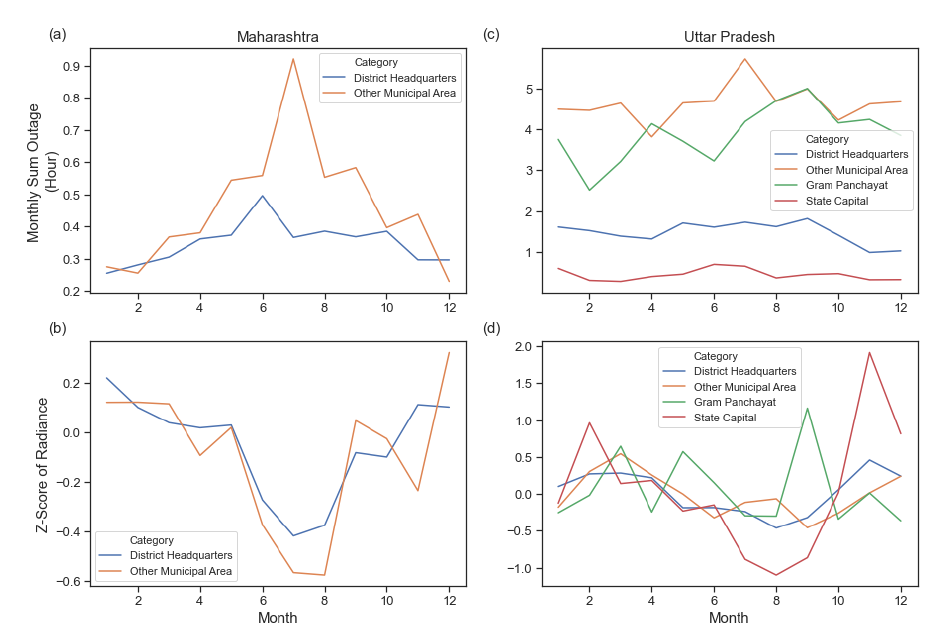
Figure 27. The monthly trend of power outage and radiance for Maharashtra and Uttar Pradesh. Upper row: mean monthly total outage hours; lower row: Z-score of monthly NTL radiance. Left column: Maharashtra; right column: Uttar Pradesh.